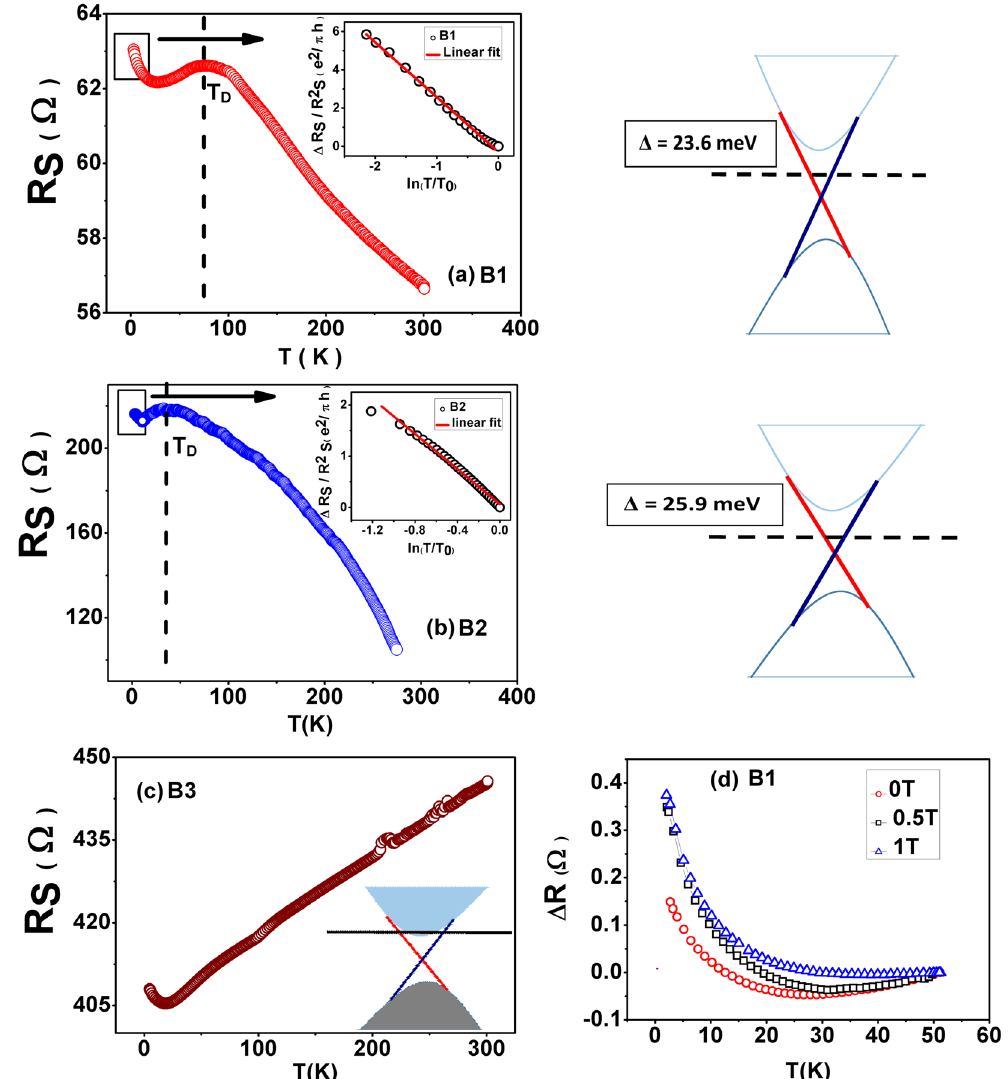
Figure 1. ( a ), ( b ) and ( c ) Resistance variation with temperature. This figure depicts the insulating behavior of BST thin films B1, B2 and metallic behavior of B3 down to 2 K. B1 and B2 display an insulating character, whereas B3 is metallic in nature ( c ). From the Hall measurements the carriers are found to be ‘n’ type (see Supplementary section). The insets of Fig. 1(a) B1 and ( b ) B2 shows the logarithmic temperature dependent resistance upturn. ( d ) Application of perpendicular magnetic field changes the slope of the upturn in the R-T behavior for sample B1. The right panels of Fig. 1(a) and (b) display the band diagrams respectively of these two samples. The dashed lines show the impurity states in the bulk band gap. The chemical potential (not shown) lies between the Dirac point and the impurity states. The band diagram of sample B3 is shown in Fig. 1(c). Here it can be seen that the chemical potential (the black horizontal line) lies in the bulk conduction